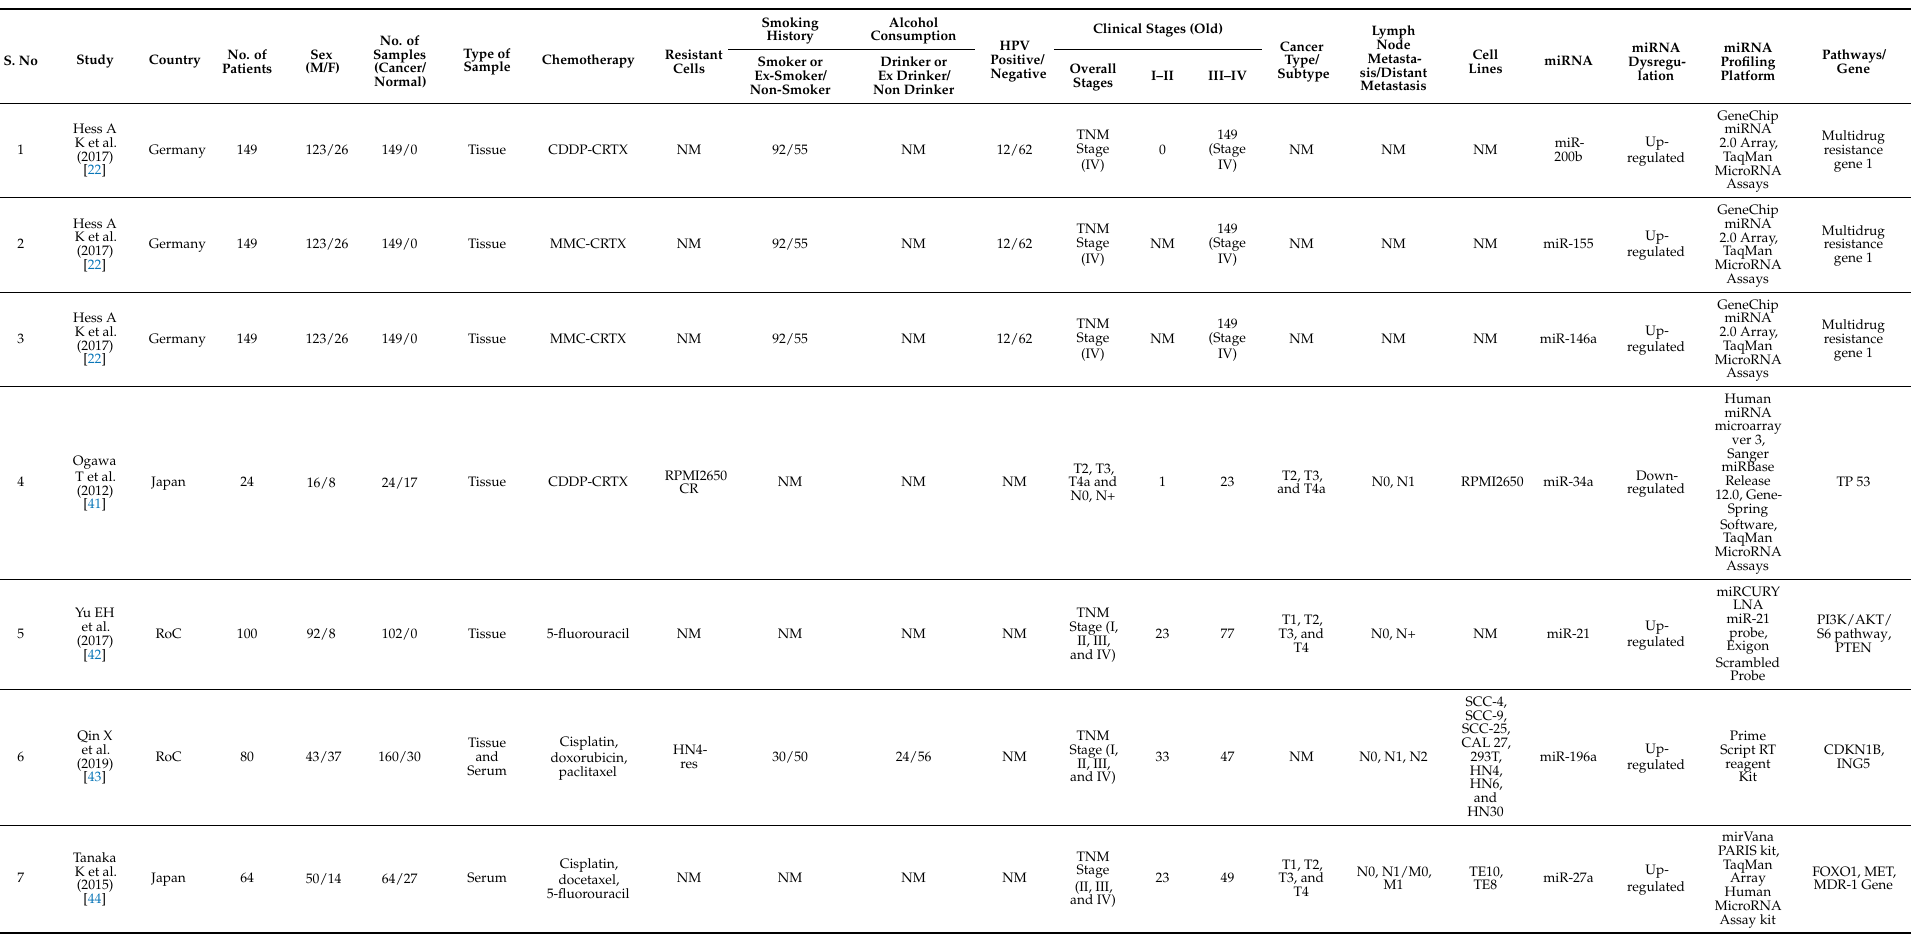
Table 3. Description of the 23 included